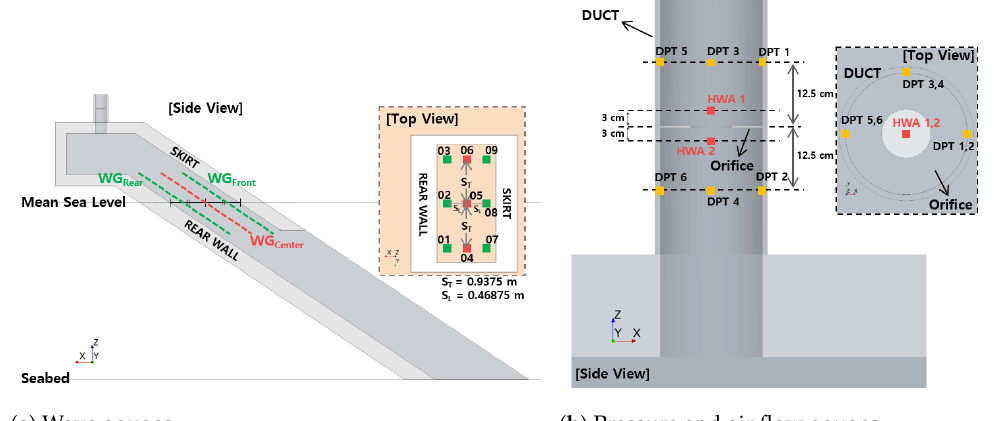
( b ) Pressure and air flow gauges. Figure 5. The locations of the internal chamber wave gauges (indicated by WG), along with the pressure sensors (indicated by DPT) and hot wire anemometer probes (indicated by HWA) inside the duct.